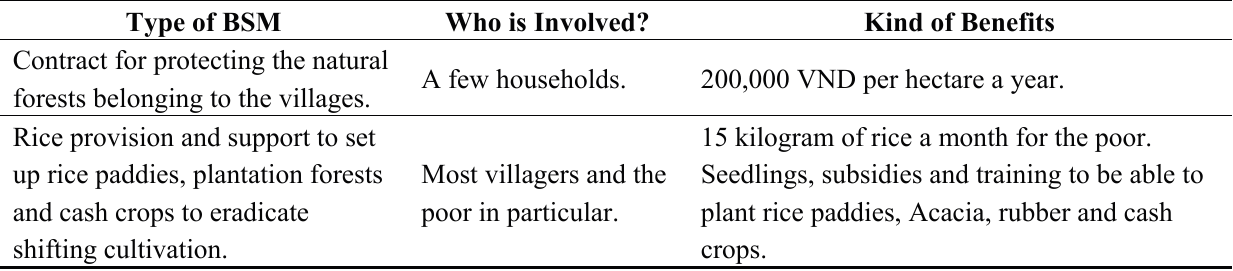
Table 3. Benefit sharing mechanisms in Huong Hiep, Da Krong